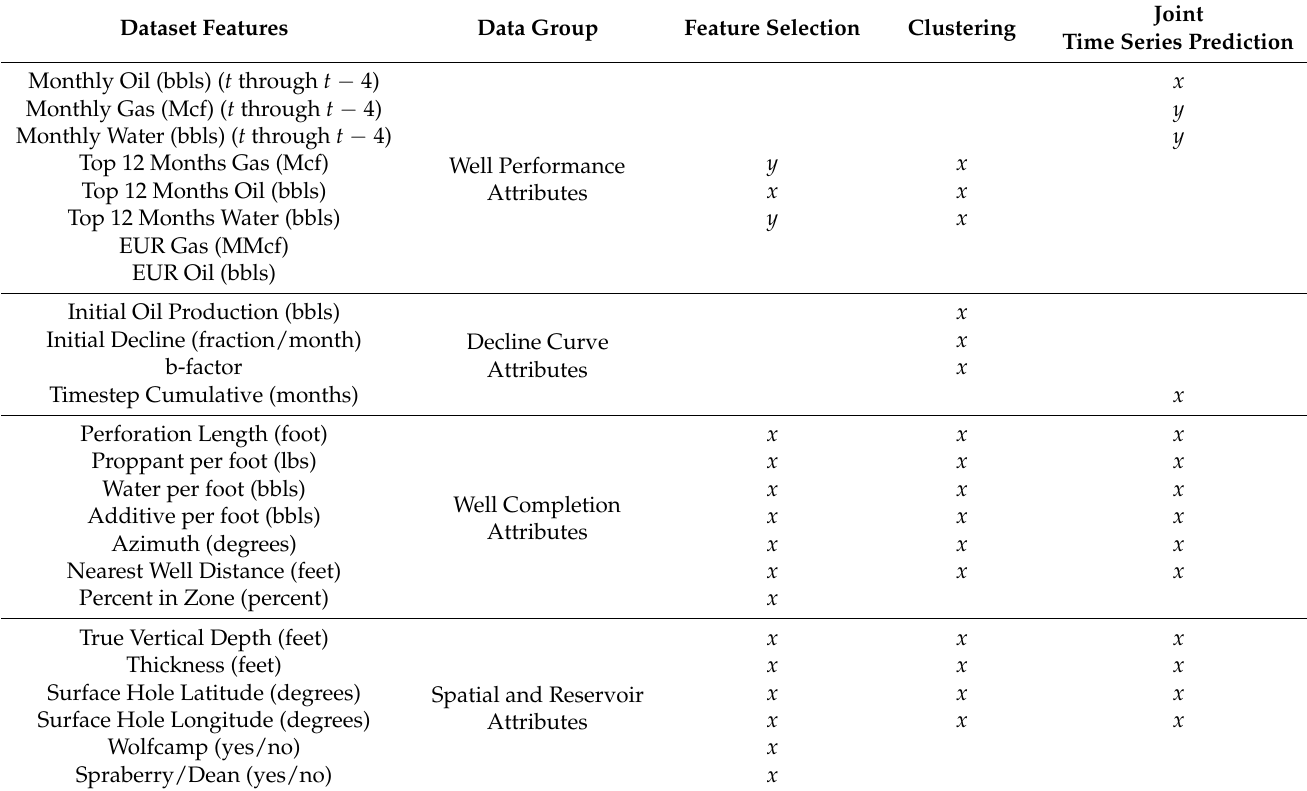
Table 4. Summary of feature inclusion for the various dataset aggregates. Each feature is